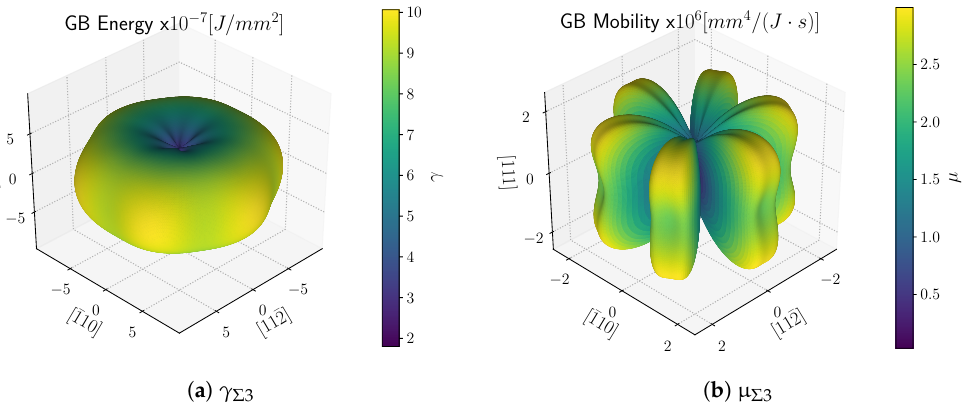
Figure 31. ( a ) GB Energy and ( b ) mobility of a Σ 3 TB in Ni computed using the fits proposed in [67] of the atomistic simulation data in the study by Olmsted et al. [4,5]. The minimum, maximum, and average values of γ and µ are 10 6 mm 4 J − 1 s − 1 × · ·